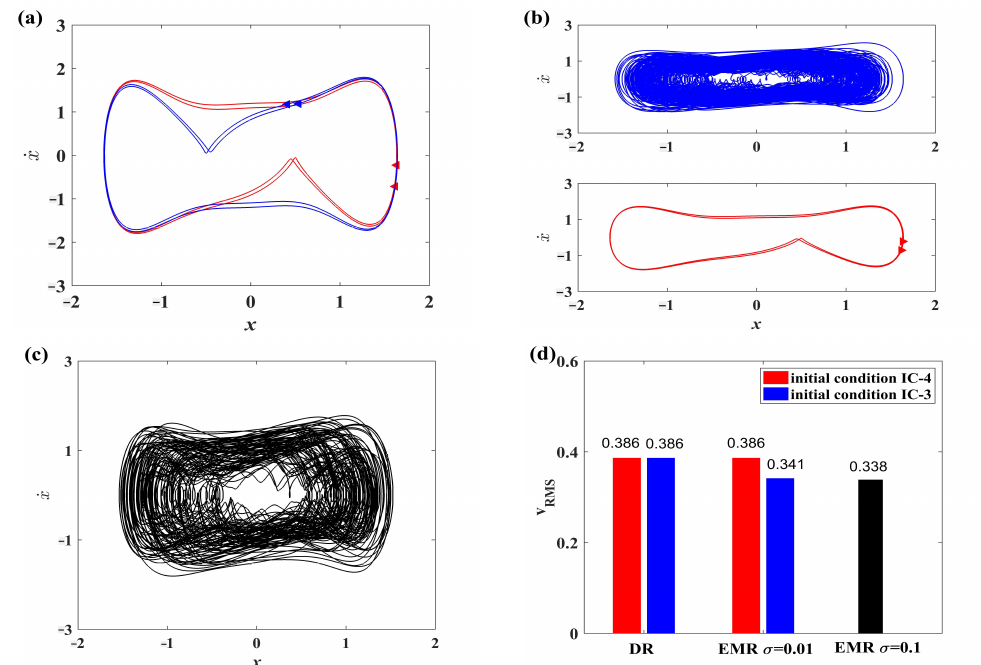
Figure 10. DR and EMR for α =0.51. ( a ) Phase portraits of DR; ( b ) Phase portraits of EMR ( σ = 0.01); ( c ) Phase portraits of EMR ( σ = 0.1); ( d ) RMS voltage of DR and EMR. The blue dots and red dots are obtained under the initial conditions (IC-3) and (IC-4), respectively.